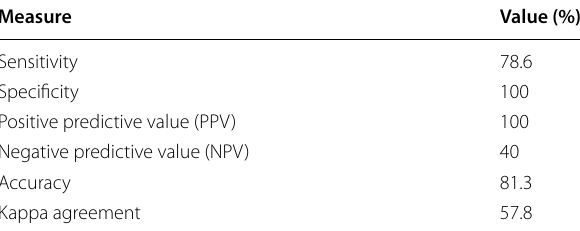
Table 3 Diagnostic yield and accuracy of microscopy using PCR